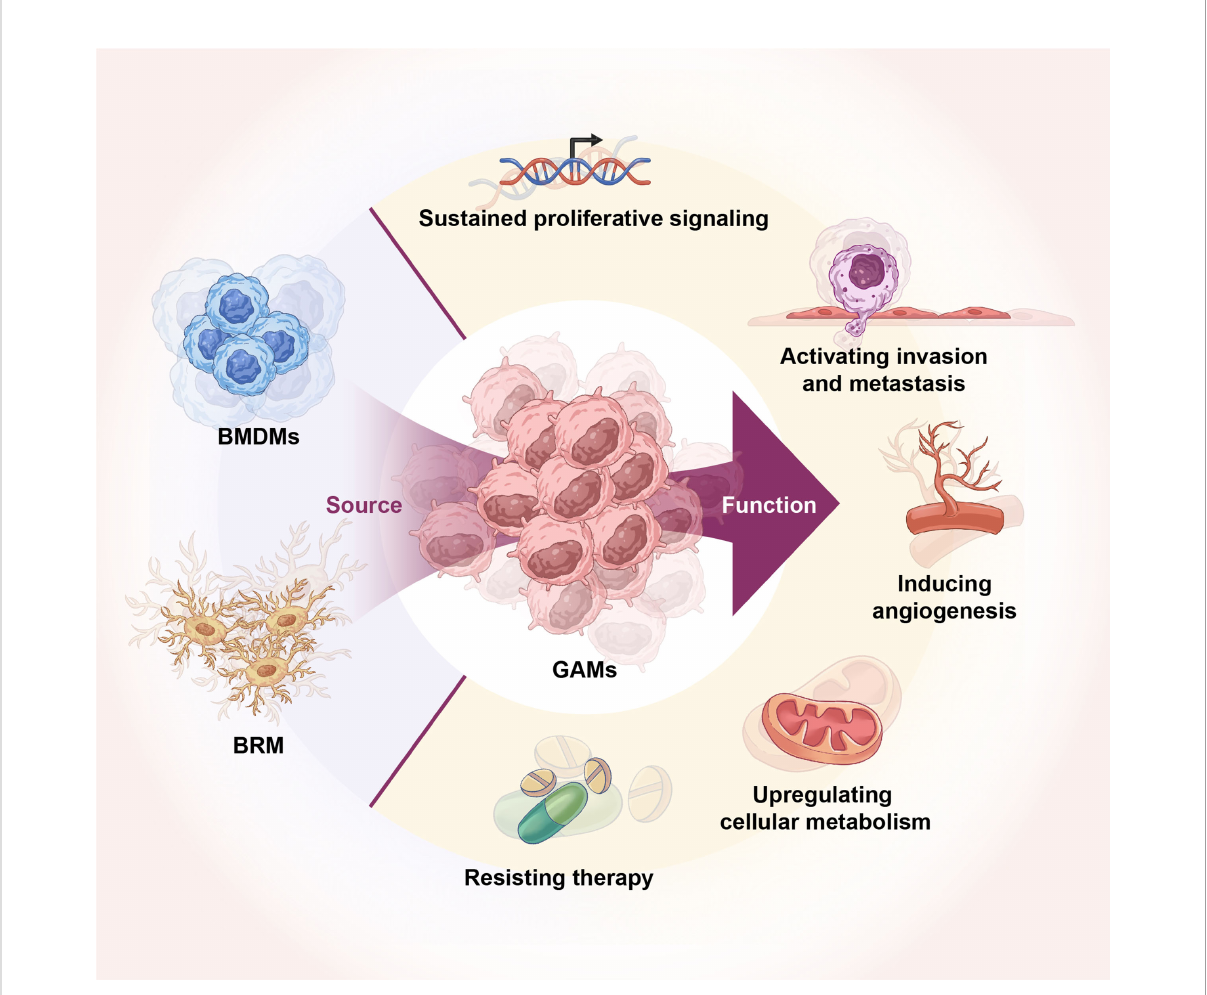
FIGURE 1 Origin of GAMs and their role in glioma. GAMs originate from BRM and BMDMs. GAMs regulate glioma tumor growth, invasion, angiogenesis, energy metabolism, and therapy